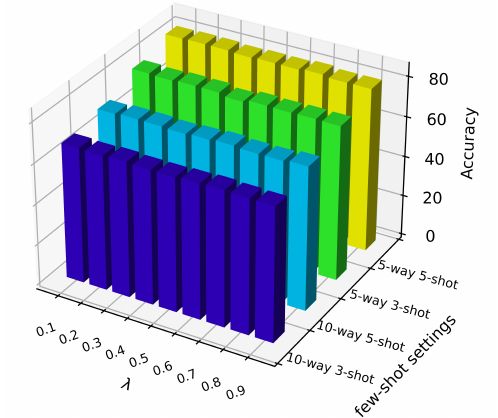
Figure 3. Node classification results based on choosing the balancing parameter λ on Amazon-Clothing.